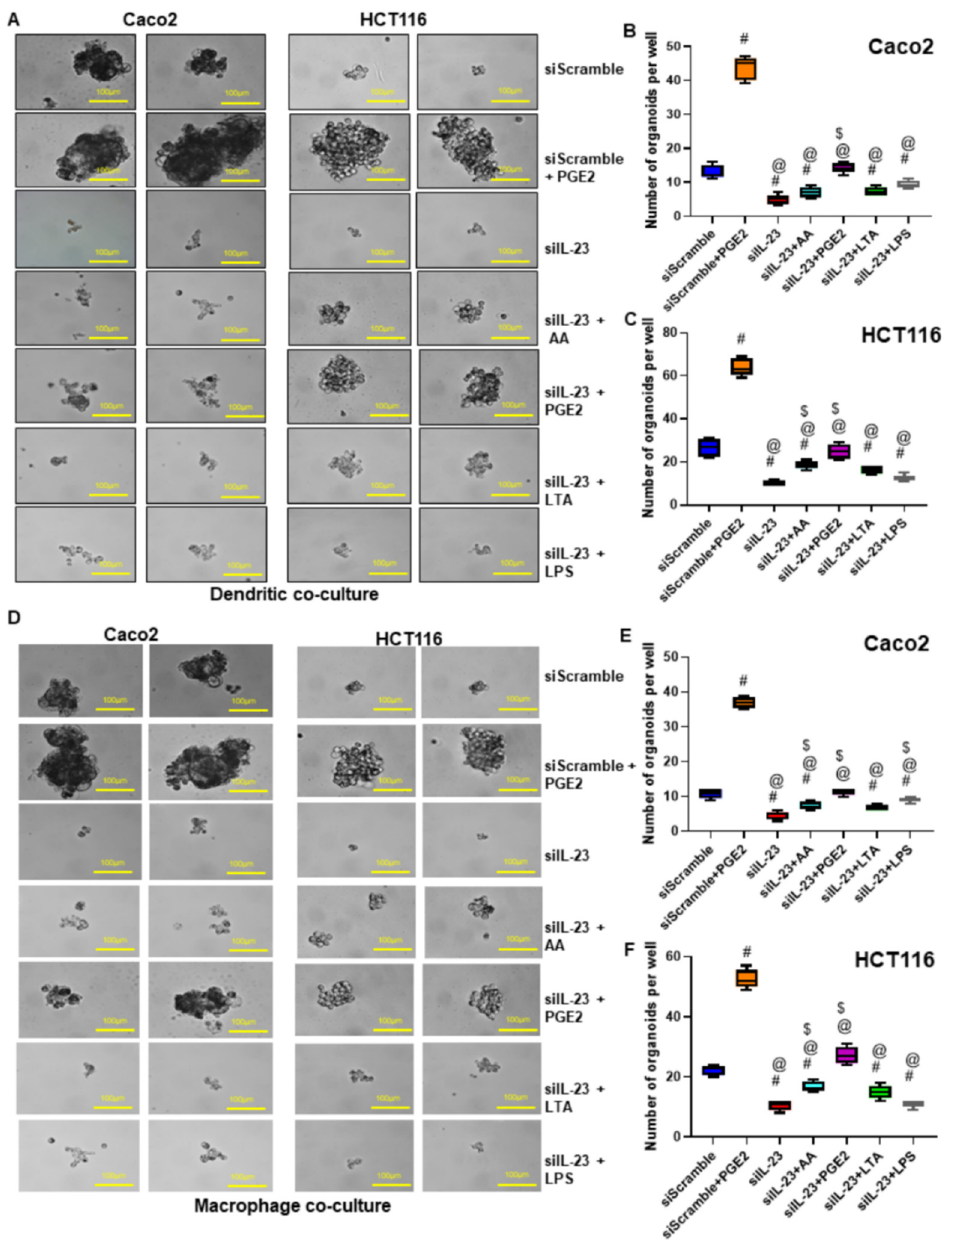
Figure 6. Inhibition of IL-23 in DCs and macrophages reduced colon tumor cell self-renewal. ( A , D ) Effect of siRNA knockdown of IL-23 in educated DCs and macrophages on the self-renewal ability of co-cultured Caco2 and HCT116 cells compared to scramble siRNA and scramble siRNA + PGE 2 stimulated immune cells (Magnification 40 × ). ( B , C , E , F ) Quantification of organoids formed per well by tumor cells co-cultured with siIL-23 treated and educated DCs and macrophages compared to scramble siRNA treated and uneducated macrophages. #-compared with siScramble; @-compared with siScramble + PGE 2 ; $-compared with siIL-23. All experiments were performed a minimum of three times. Bars denote standard deviation (SD). * p < 0.05, ** p < 0.01, and *** p < 0.001 were considered statistically significant.